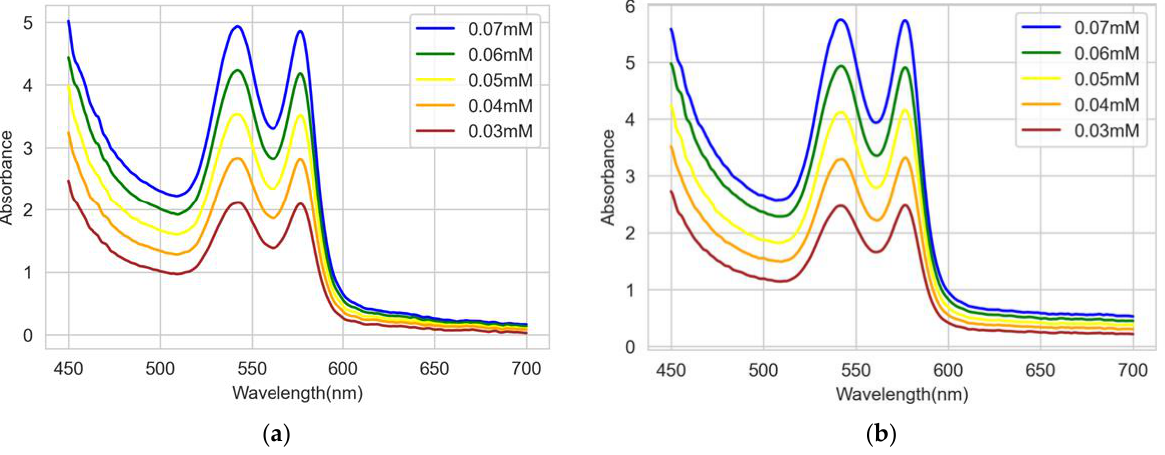
Figure 5. Absorbance spectra of Bio-Rad Lyphocheck diabetes solutions for different concentrations for ( a ) level 1 and ( b ) level 2.